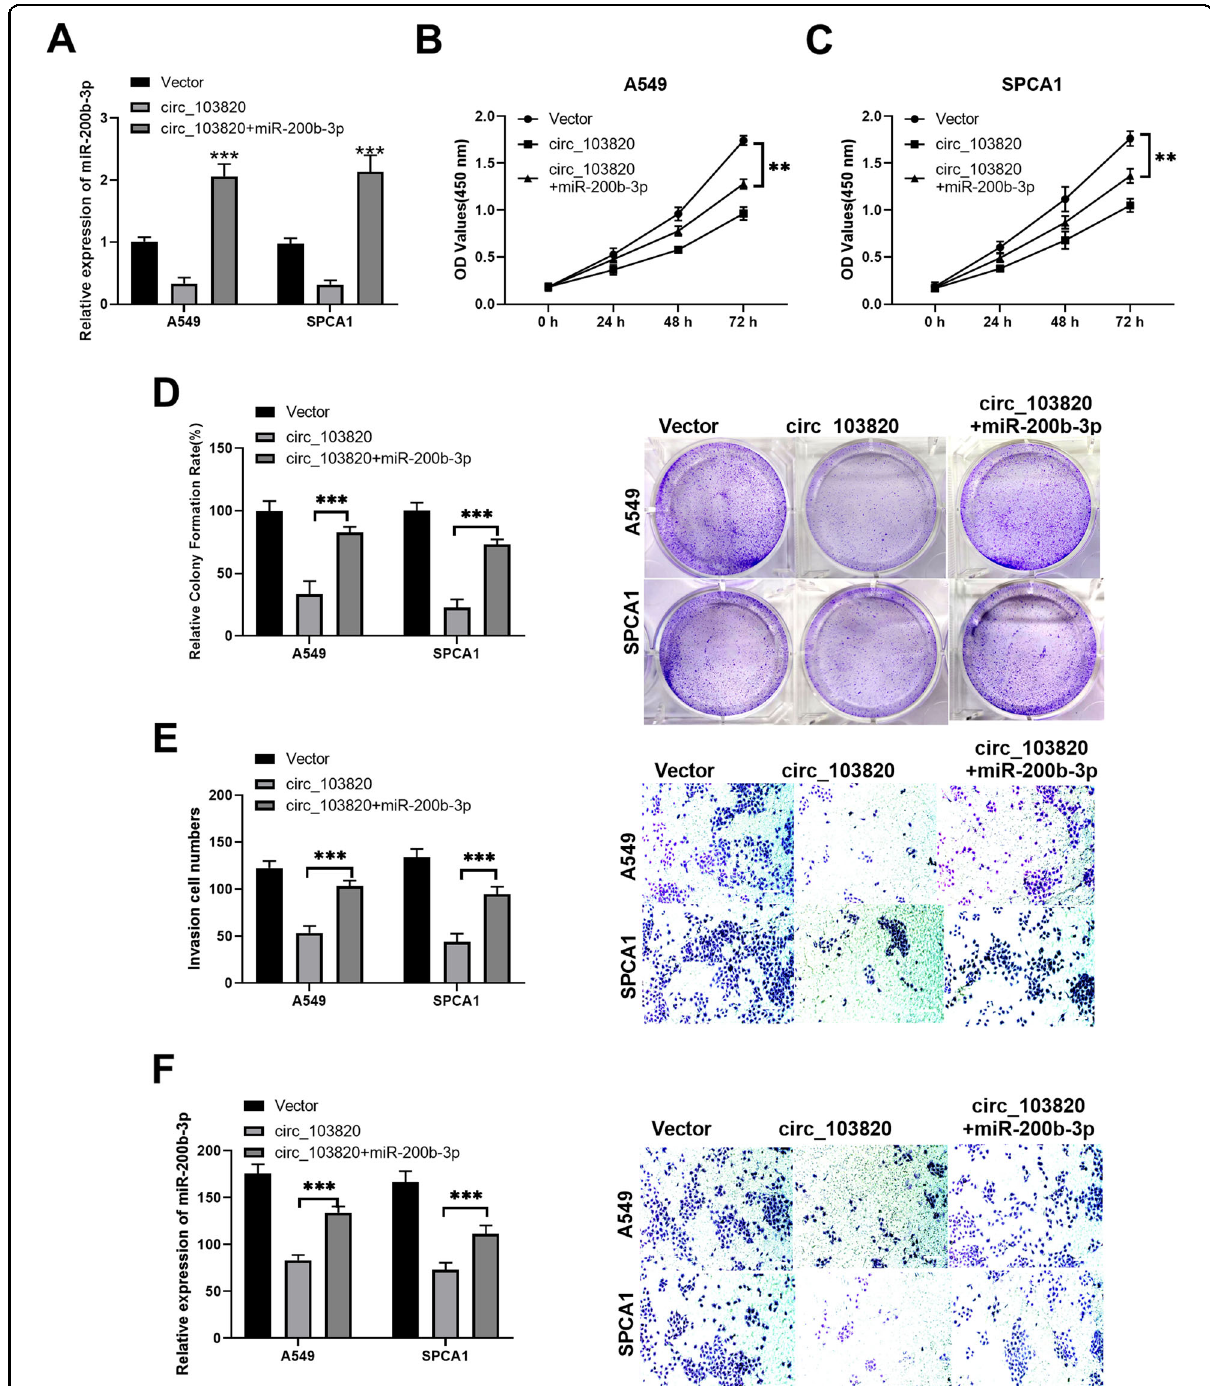
Fig. 6 miR-200b-3p reversed the inhibitory effects of hsa_circ_103820 on proliferation, migration, and invasion in lung cancer. A549 and SPCA1 cells were cotransfected with hsa_circ_103820 plasmid or/and miR-200b-3p mimics. A miR-200b-3p expression was monitored using qRT-PCR assay. B – D Cell proliferation was examined via CCK-8 and colony formation assays. E, F Transwell experimental analysis in the treated A549 and SPCA1 cells. Scale bars, 100 μ m. Data are mean ± SD, n = 3. *** P < 0.001, ** P < 0.01 (Student ’ s t